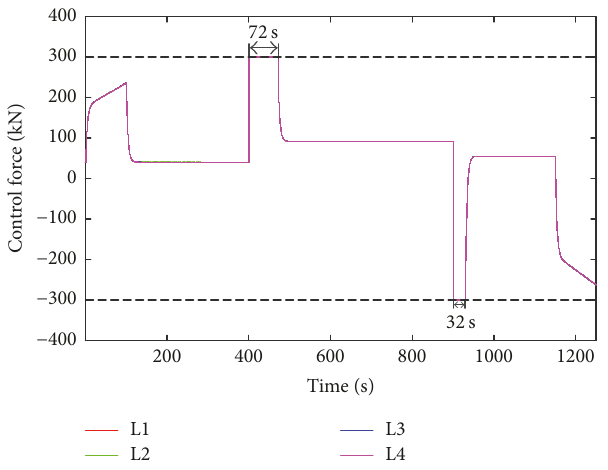
Figure 5: The force output of each locomotive in Scenario A.